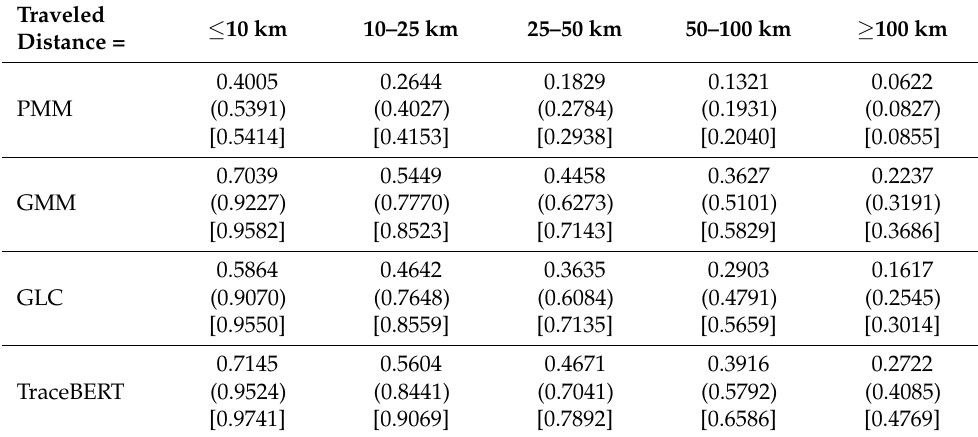
Table 2. Comparison of top-1 accuracy, top-3 accuracy (in round brackets), and top-5 accuracy (in square brackets) for different ranges of traveled